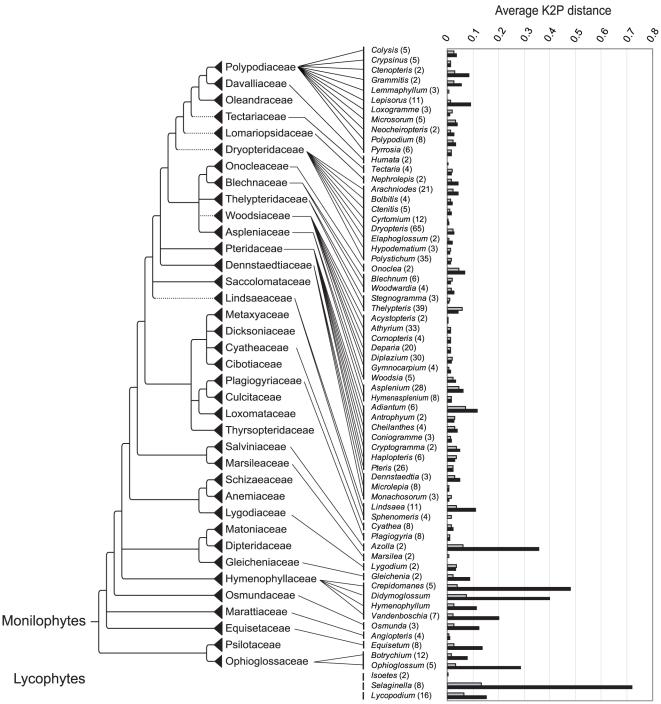
Average interspecific K2P distances for each genus containing multiple taxa (θ' values).Infraspecific taxa are treated as distinct species. θ'values are placed upon the latest family-level classification [36]. Gray: rbcL, black: trnH-psbA.